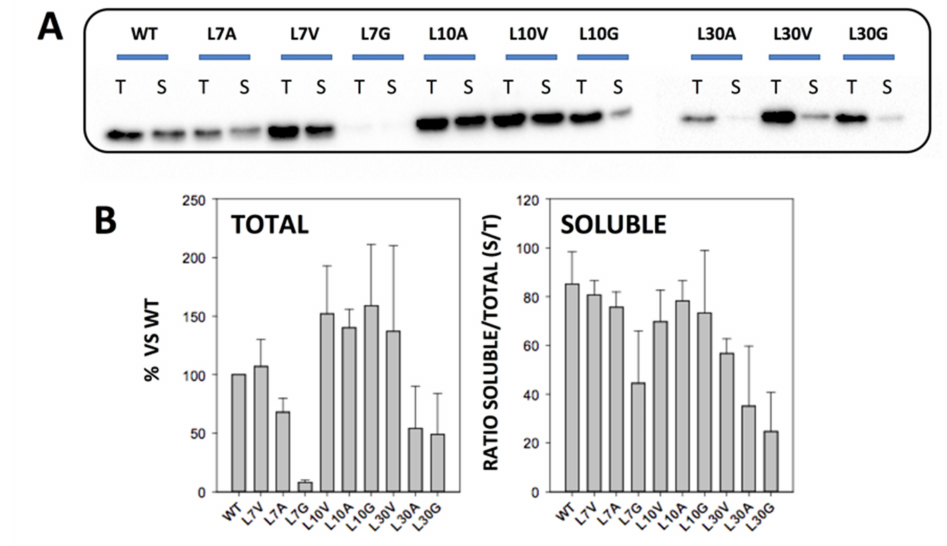
Figure 2. Expression levels and solubility of NQO1 variants. ( A ) Representative Western blot analysis of NQO1 total (T) and soluble (S) extracts from E. coli cells; ( B ) Quantitative analysis of NQO1 from expression levels (from six independent experiments; mean ± s.d.) solubility is displayed as the ratio of soluble/total protein. Expression was carried out at 37 ◦ C for 4 h upon induction with IPTG 0.5